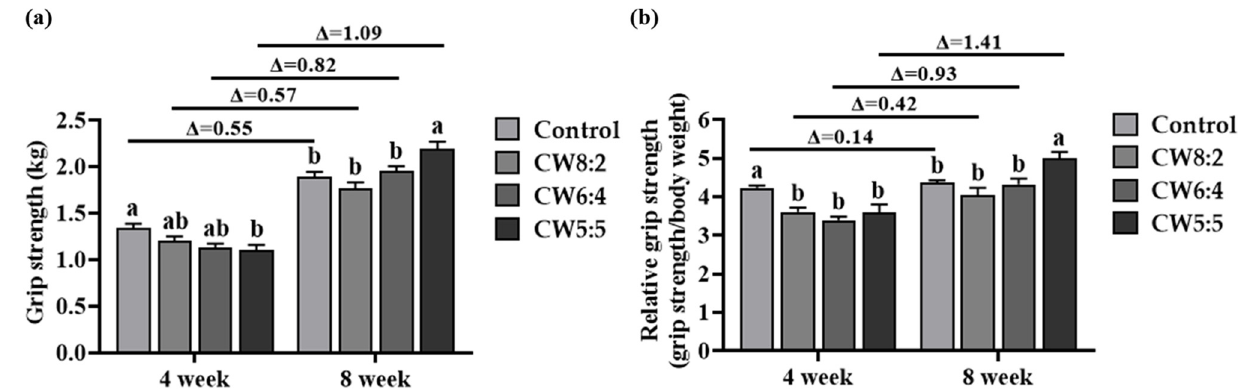
Figure 3. ( a ) Absolute and ( b ) relative grip strength at weeks 4 and 8 in rats administered milk with adjusted casein to whey proteins ratios for eight weeks ( n = 6). Data are expressed as mean ± SEM. The values with different letters indicate significant differences at p < 0.05. CW, casein:whey pro- teins; ∆ , difference between grip strength at weeks 4 and